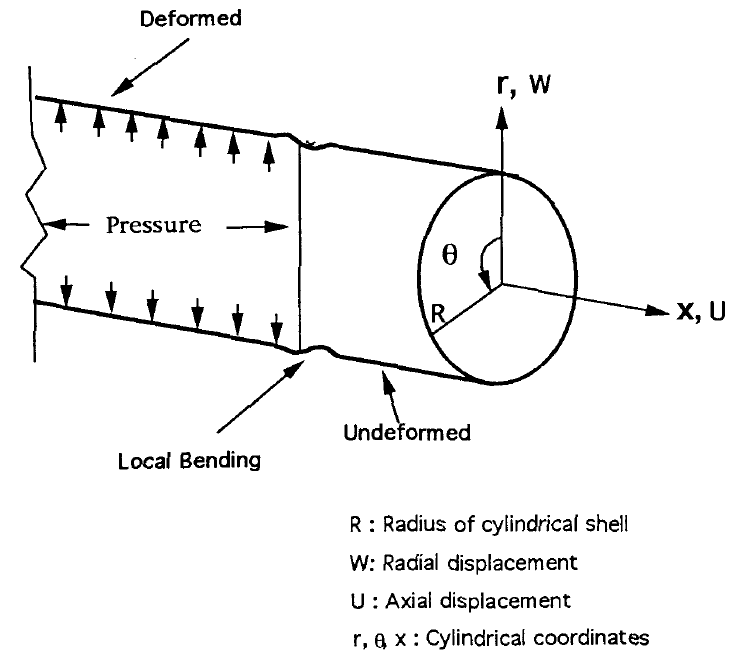
Fig. 2. Deformation of cylinder subjected to a moving pressure